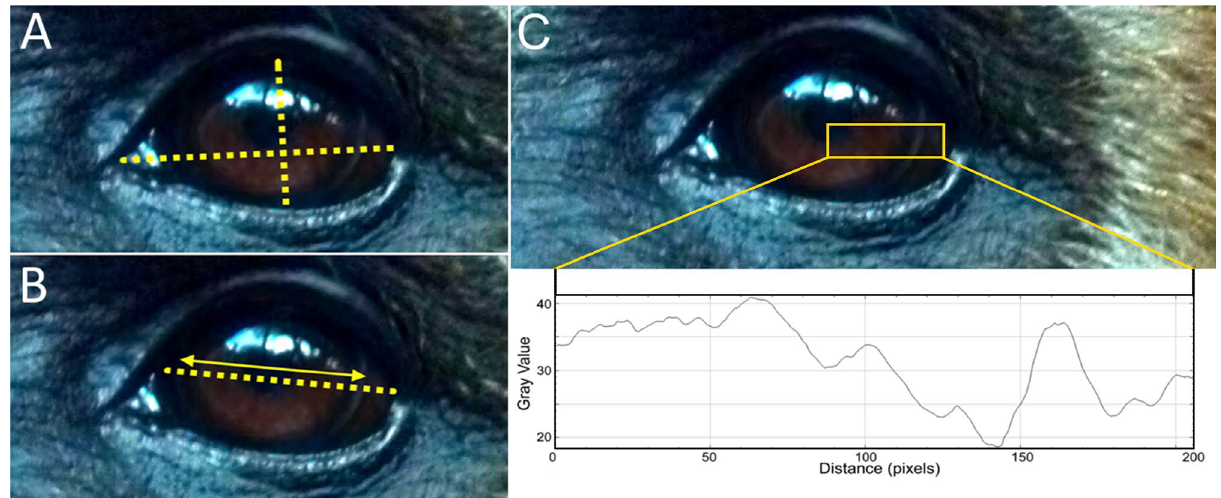
Figure 1. Visualization of ocular measurements exemplified on a white-handed gibbon ( Hylobates lar ). ( A ) Measurements of width and height of the eye taken to calculate a ratio (width-height ratio, WHR). ( B ) Measurements of the width of visible sclera and iris to calculate a ratio (scleral size index, SSI). ( C ) Deriving ocular luminance measurements (HC, RIL) from gray values in ImageJ using the plot profile function. Photo credit: Thomas